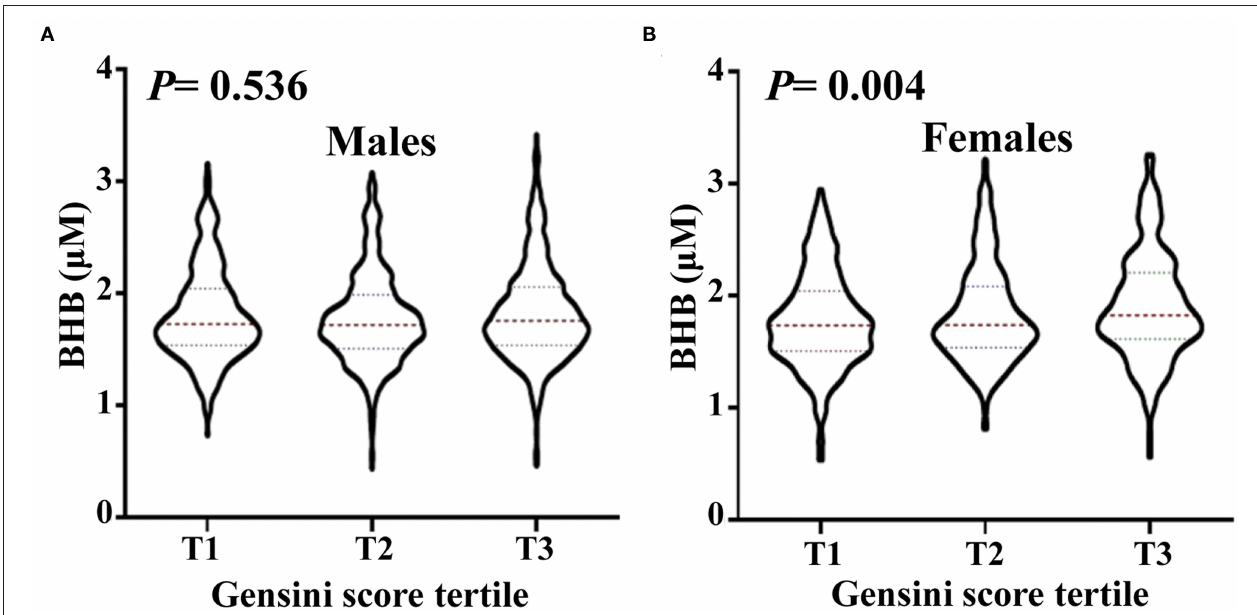
FIGURE 3 | The level of circulating BHB in men and women, respectively, according to Gensini score tertile. Violin plots of serum BHB concentrations in men (A) and women (B) by Gensini score tertile, showing median (red dashed line) and interquartile ranges (blue dashed line) on a log10 scale. The p < 0.05 considered statistically significant.